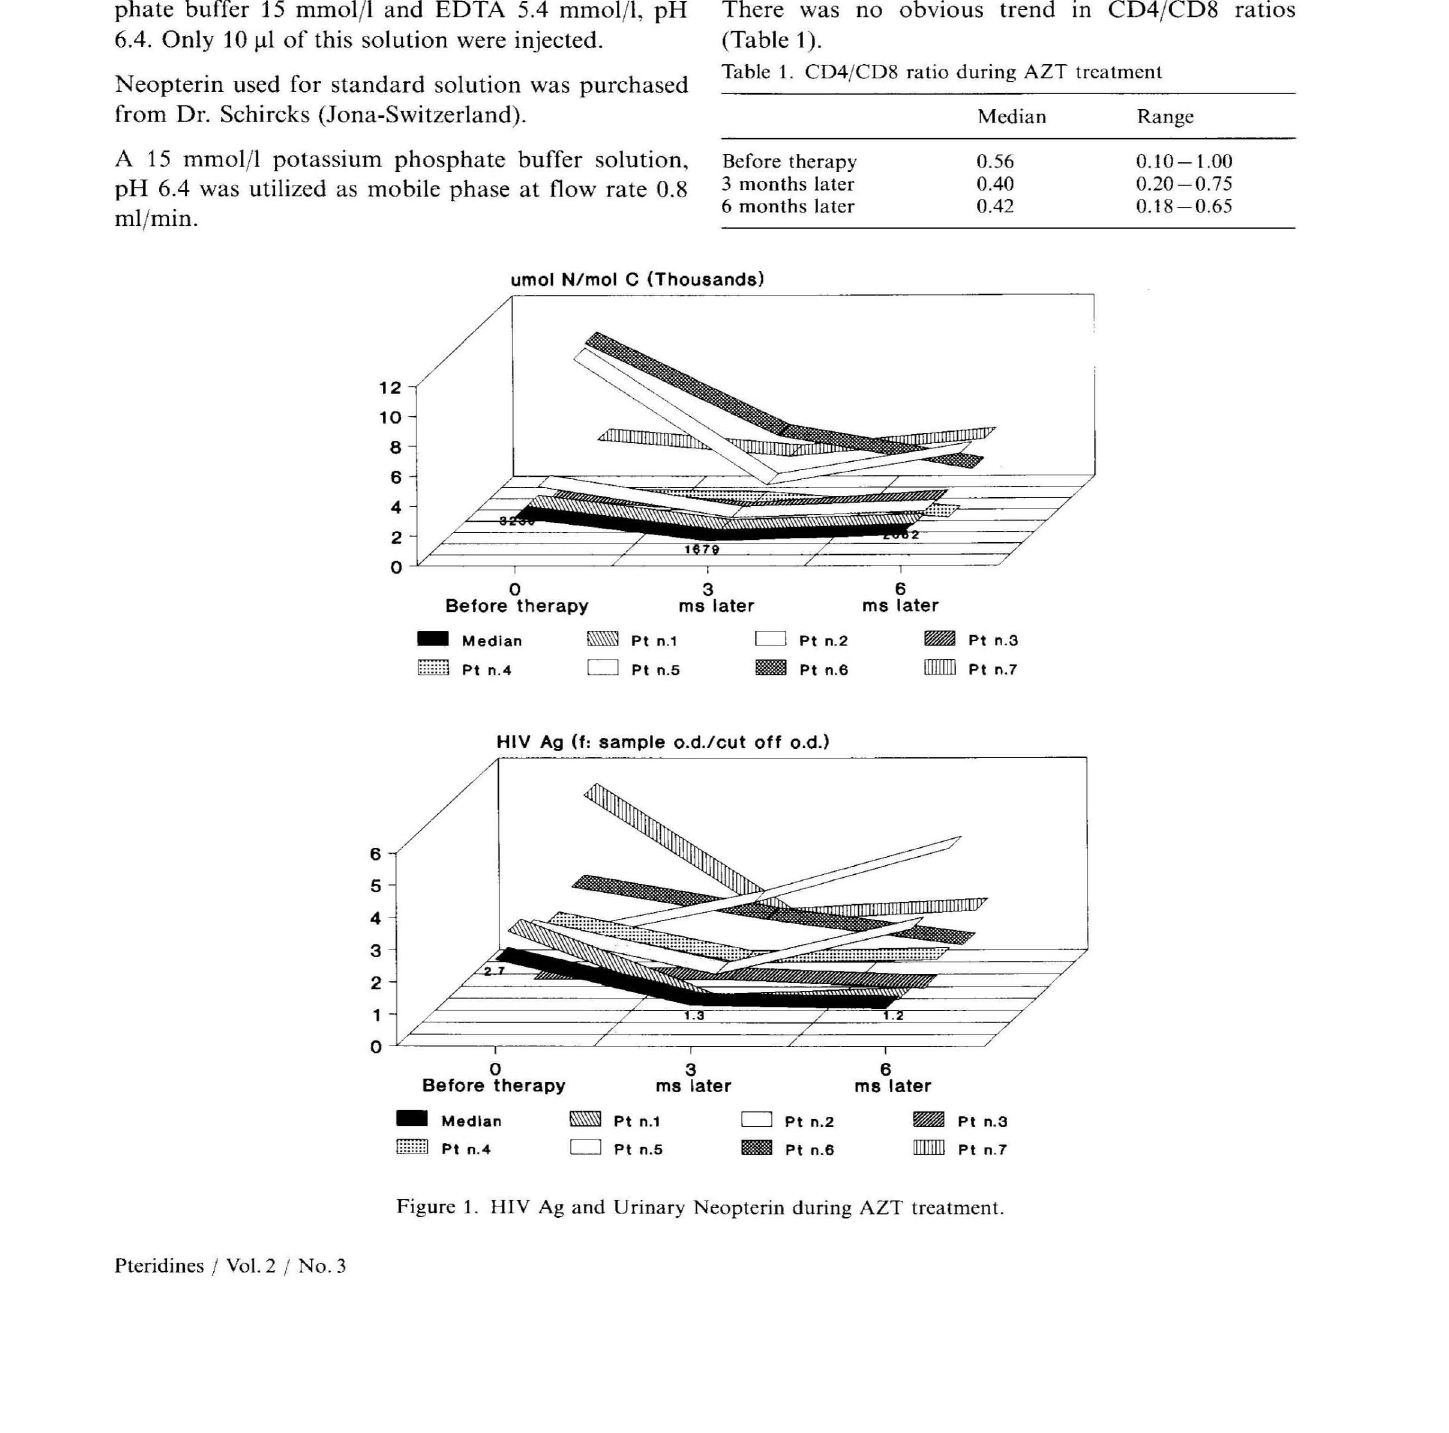
Table 1. CD4/CD8 ratio during AZT treatment